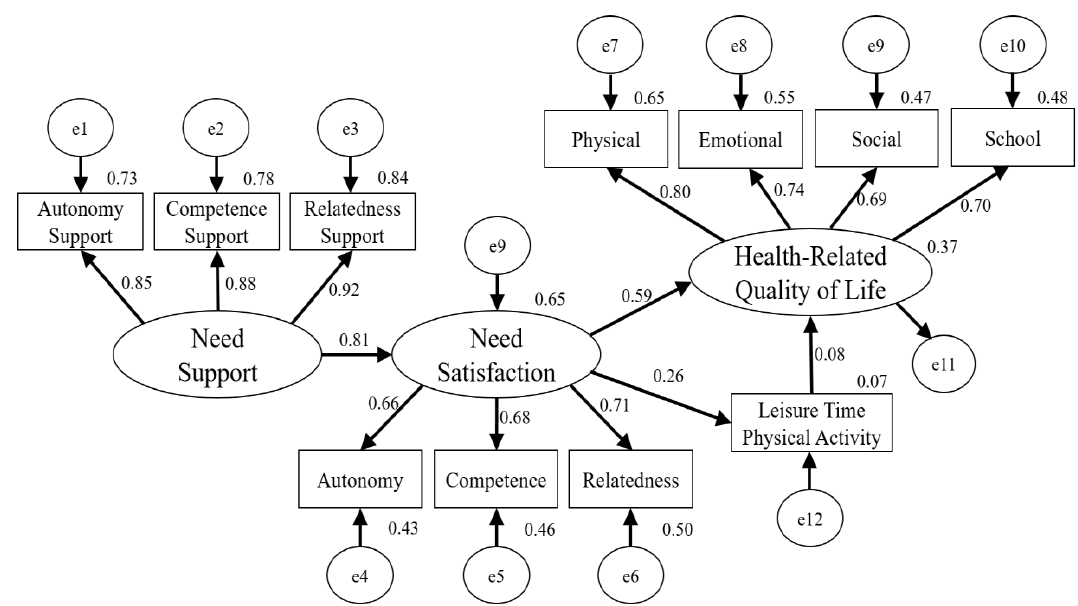
Figure 2. Final Structural Model of the Study Variables. Note. Circles represent latent variables, and squares represent observed variables. All paths are significant at p < 0.05.